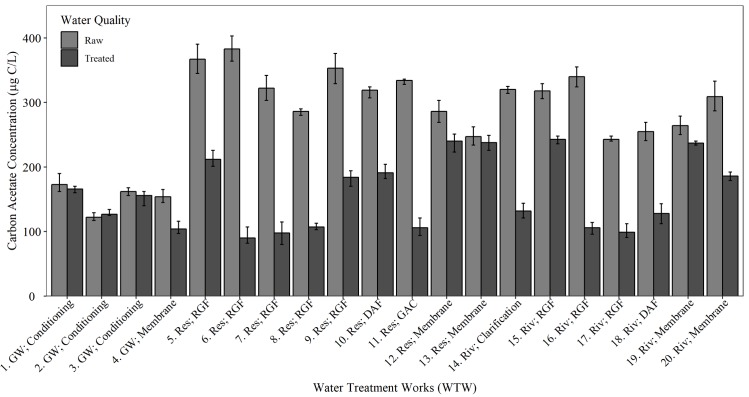
AOC concentration in raw (light bar) and treated (dark bar) water at 20 WTW (Table 1 for details of source water, treatment type and disinfectant) [26].Data collected weekly over a two month period, average is presented (n = 24) ± standard deviation. Figure axis include the identification (ID) number of each WTW (1-20), the water source (GW = groundwater, Res = reservoir, Riv = river) and treatment type (RGF = rapid gravity filter, DAF = dissolved air flotation, GAC = granular activated carbon).